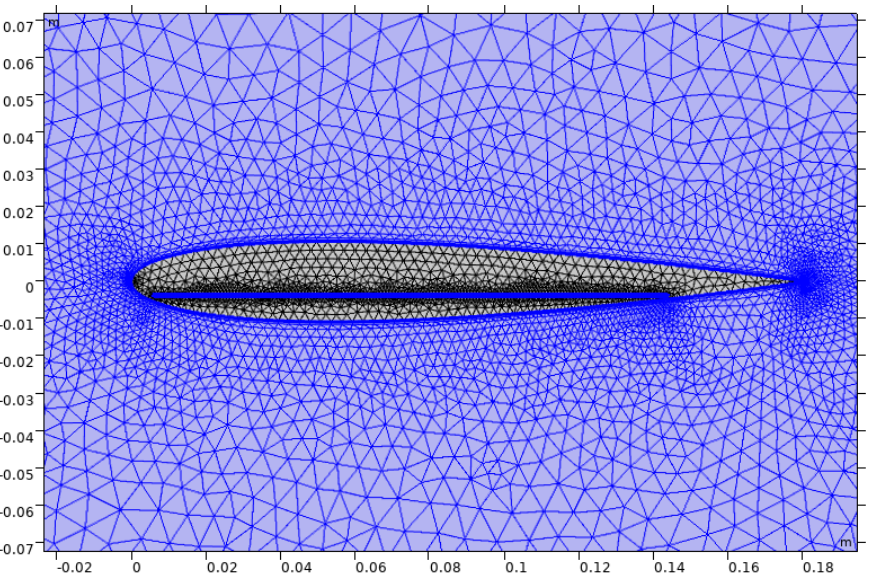
Figure 4. Detail of the employed grid. Blue and black colors are used to emphasize the different phases in the control